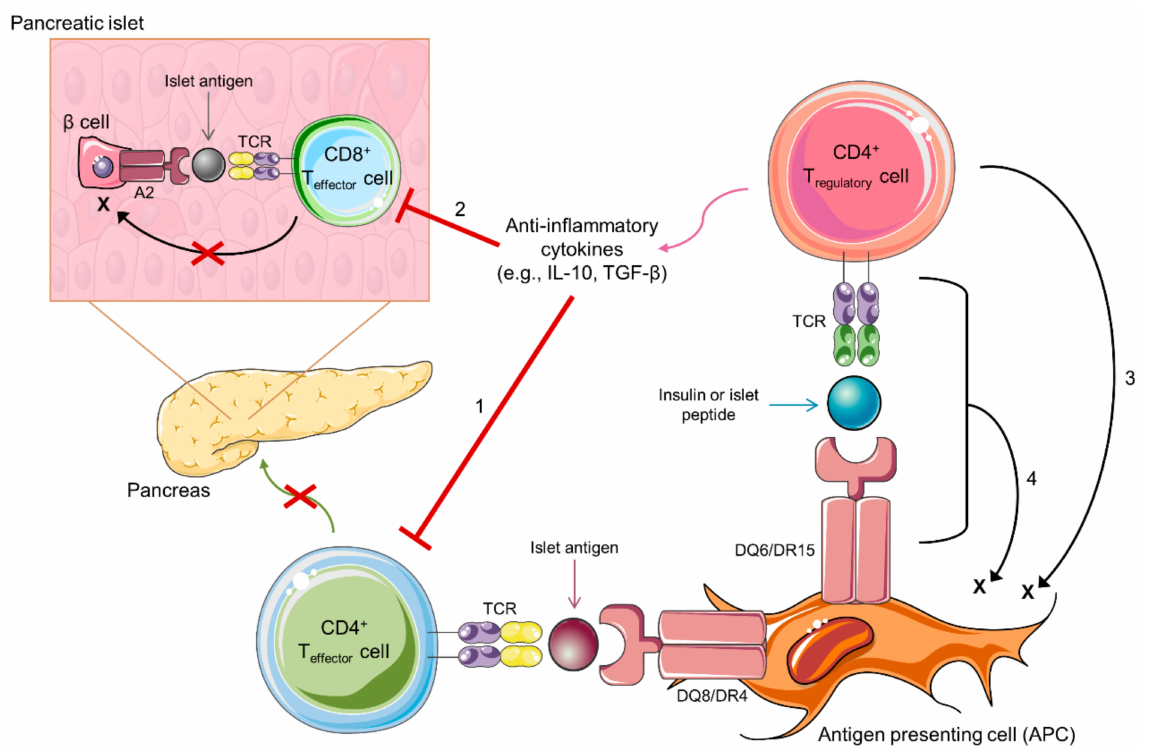
Figure 2. Potential mechanisms for protection from type 1 diabetes development by antigen-specific regulatory T cells. Depicted is a CD4+ regulatory T cell (Treg) recognizing an insulin or islet peptide in the context of diabetes-protective HLA-DQ6 or DR15. This interaction leads to the production of anti-inflammatory cytokines (e.g., IL-10 and TGF- β ), and the activation of these antigen-specific Tregs can protect from beta cell destruction by four potential mechanisms. ( 1 ) CD4+ effector T cells recognize islet antigens presented by diabetes-risk conferring HLA-DQ8 or DR4 on antigen-presetting cells (APCs) and then migrate to the pancreas where they induce pancreatic beta cell destruction. Antigen-specific Tregs can suppress CD4+ effector T cells and prevent the trafficking of these cells to the pancreas via the release of anti-inflammatory cytokines. ( 2 ) CD8+ T effector cells in the pancreatic islets recognize islet antigens presented by HLA-A2 on pancreatic β cells, leading to the destruction of the β cells. Tregs can suppress CD8+ effector T cells and prevent β cell destruction via the release of anti-inflammatory cytokines. ( 3 ) Tregs can target APCs via granzyme-mediated killing in an antigen-independent manner or ( 4 ) potentially in an antigen-dependent manner when the cognate self-peptide is presented to the Treg T cell receptor